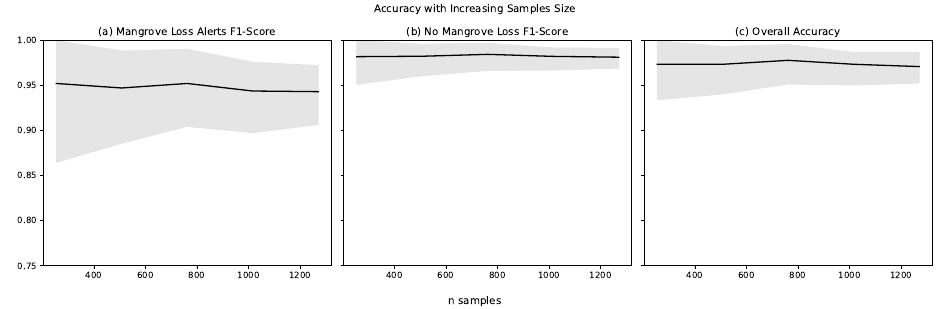
Figure 12. To illustrate that a sufficient number of accuracy samples has been used for the accuracy assessment, the reference data were subsampled and cumulatively combined to calculate the ( a ) the F1-score for the mangrove loss alerts, ( b ) the F1-score for pixels with no mangrove loss and ( c ) the overall accuracy. The grey areas illustrate the 95th confidence interval of the accuracy metric, where values closer to 1.0 indicate better accuracy. For all three metrics, including additional reference data does not significantly alter the accuracy estimated, and therefore, it can be concluded that sufficient reference data has been